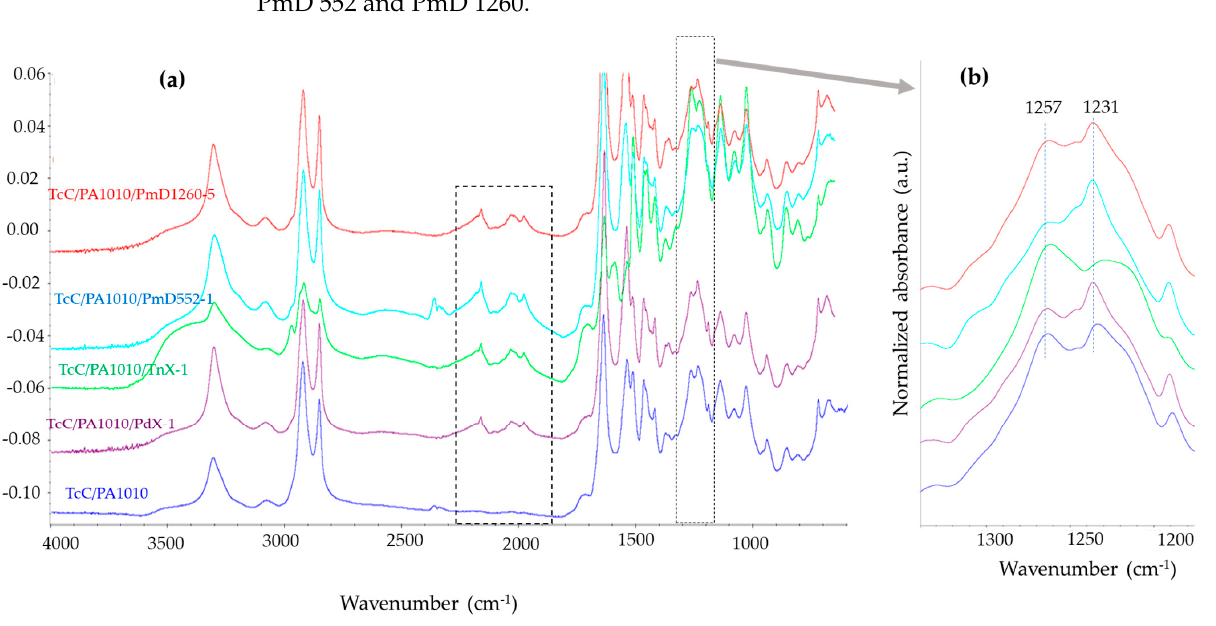
Figure 3. FTIR spectra of TcC/PA1010 and TcC/PA1010 blends containing PdX, TnX, PmD 552 and PmD 1260 cross-linkers: ( a ) 800 − 4000 cm − 1 and ( b ) 1100 − 1400 cm − 1 range.